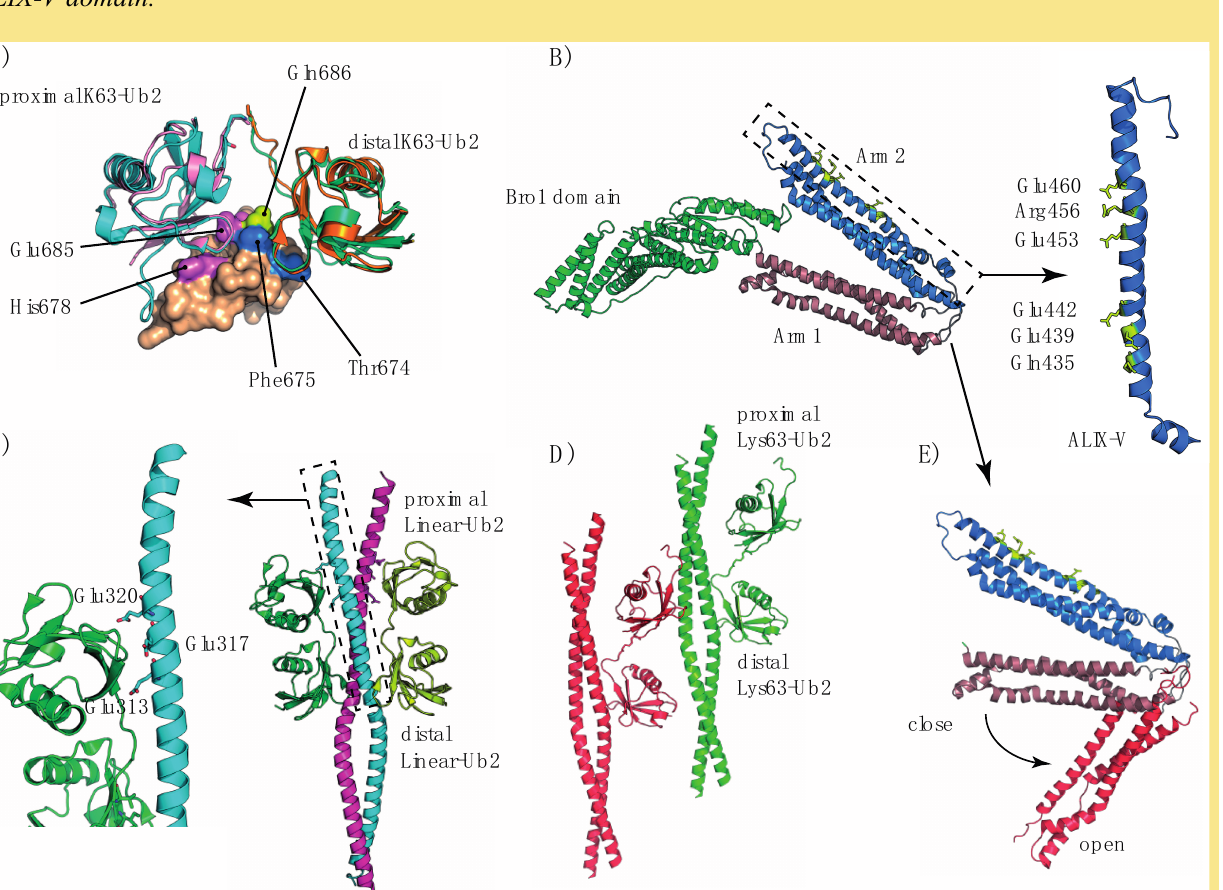
Figure I. ( A ) Different X-ray structures of the TAB2NZF/Lys63-Ub2 complex, PDB code 3A9J (orange and cyan for the distal and proximal Ub respectively) and PDB code 2WWZ (green and pink for the distal and proximal Ub respectively). The structures are aligned with respect to the TAB2 NZF domain (represented by a solvent- accessible surface) of the 3A9J structure. ( B ) Structural organization of the ALIX BRO1-V domains, showing arms1-2 in a close conformation (PDB code 2OEV). The right inset presents an expanded view of the first ALIX- V triad similar to that of NEMO UBAN. ( C ) Structure of the NEMO-UBAN domain in complex with linear-Ub 2 chains, along with an expanded view of the triad conserved with respect to the ALIX-V domain. ( D ) Structure of the NEMO-UBAN domain in complex with Lys63-Ub (PDB code 3JSV), in which the Lys63-Ub proximal domain 2 2 binds to another NEMO dimer. ( E ) Comparison of the open (PDB code 4JJY) and closed conformations of the ALIX-V